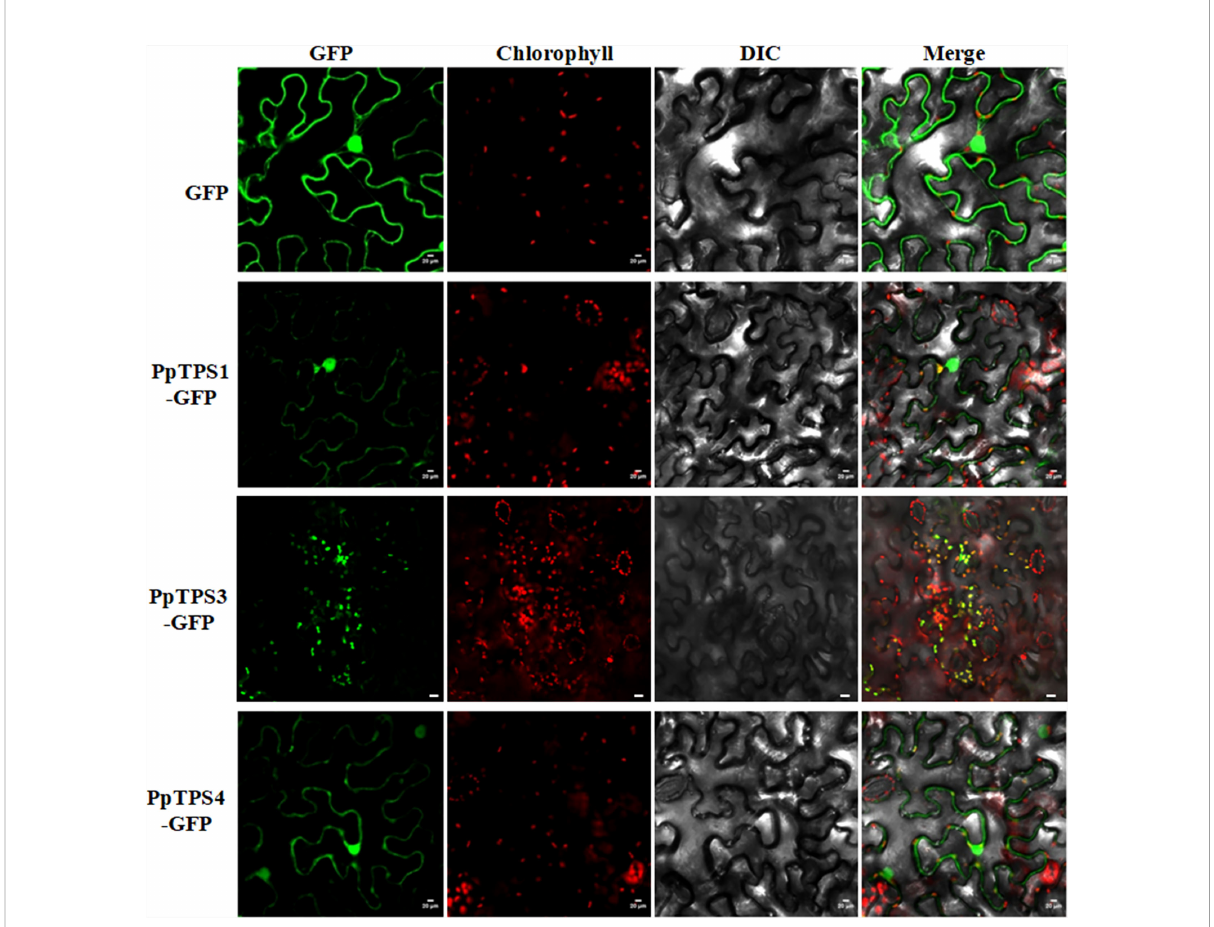
FIGURE 6 Subcellular localizations of three PpTPS-GFP fusion proteins in the leaves of Nicotiana benthamiana . The primers used for gene cloning were listed in Supplementary Table